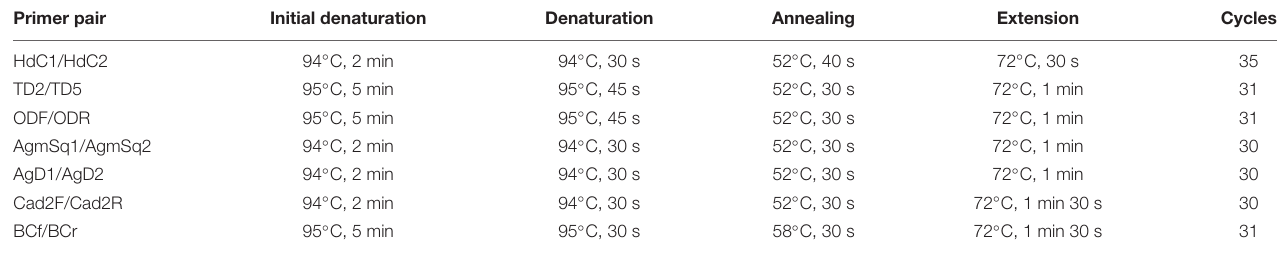
TABLE 2 | PCR protocol of each gene. Primer